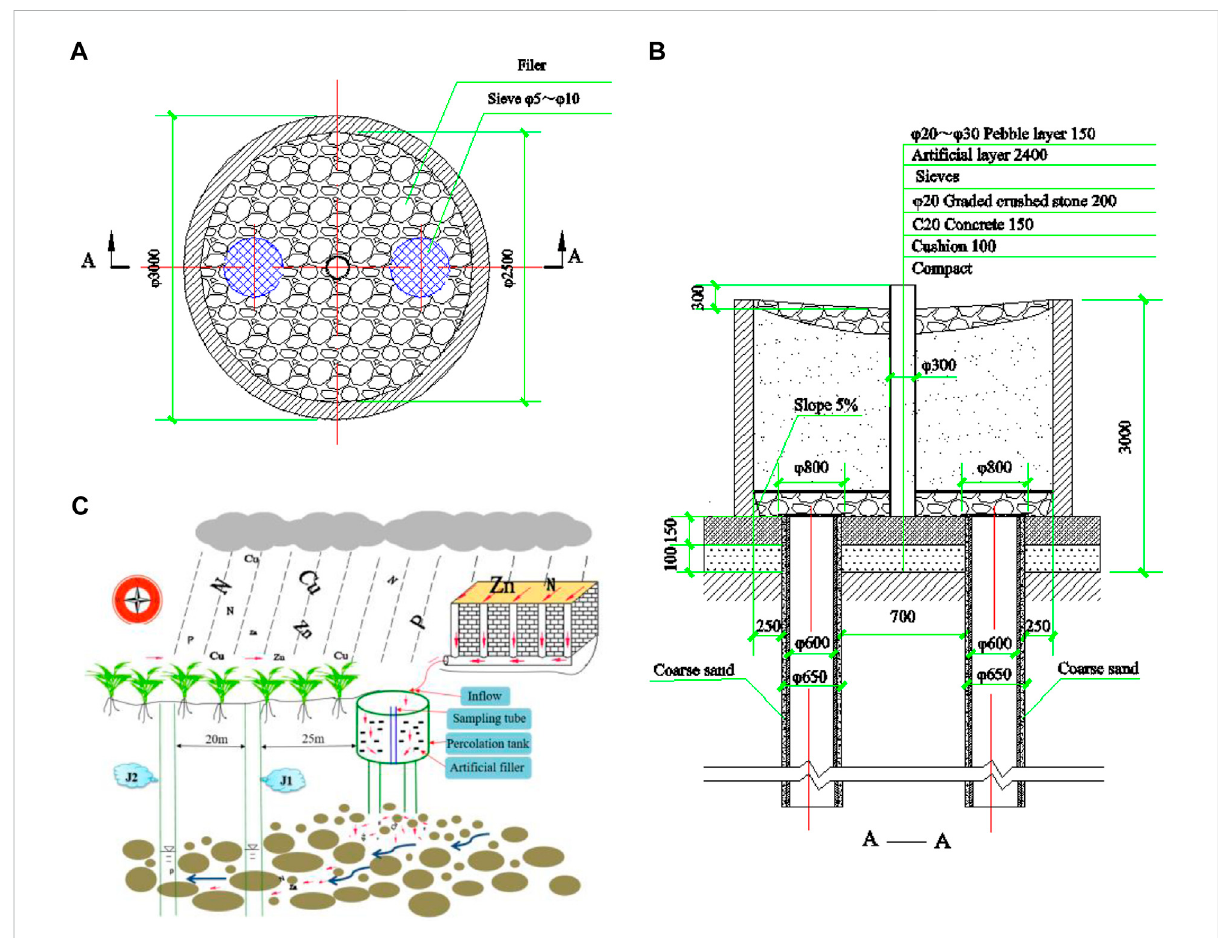
FIGURE 2 CRIs structure and fl owchart. Note: (A) the bottom structure of the percolation tank; (B) CRIs structure; (C) fl owchart.